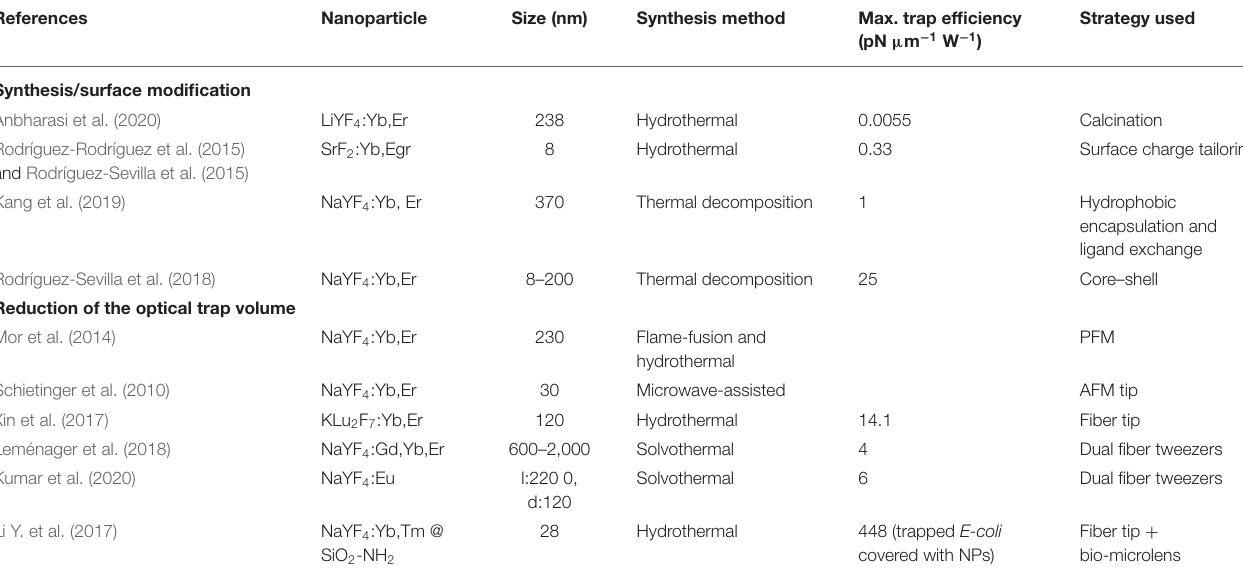
TABLE 1 | Classification of the most relevant techniques used on NPs:Ln to enhance their optical